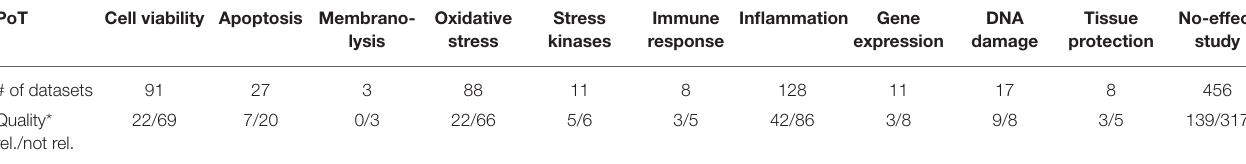
PoT Cell viability Apoptosis Membrano-